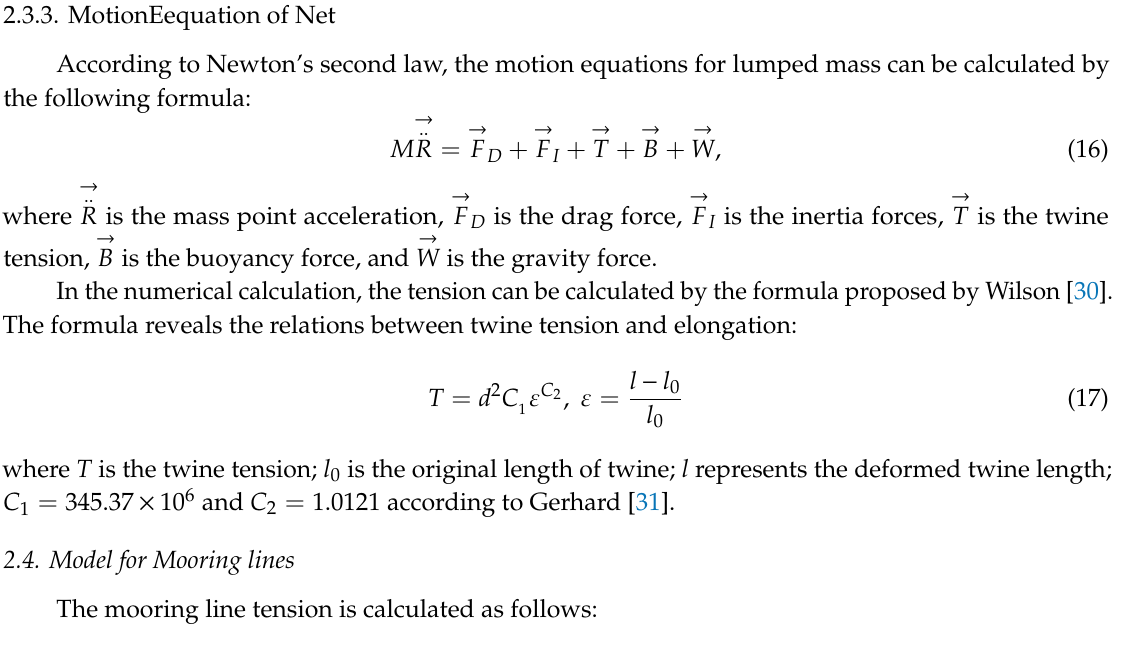
Figure 4. Local coordinate system for a net element.